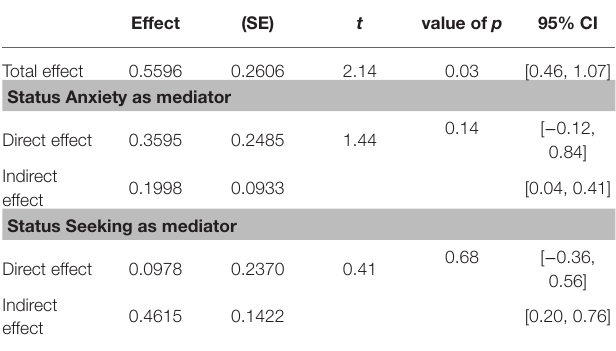
TABLE 3 | Total, direct, and indirect effects of the economic inequality on status